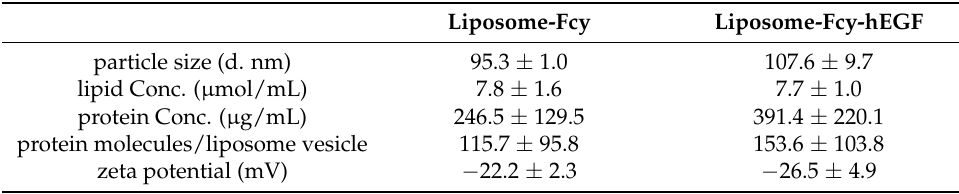
Data are expressed as means ± SD ( n = 4).